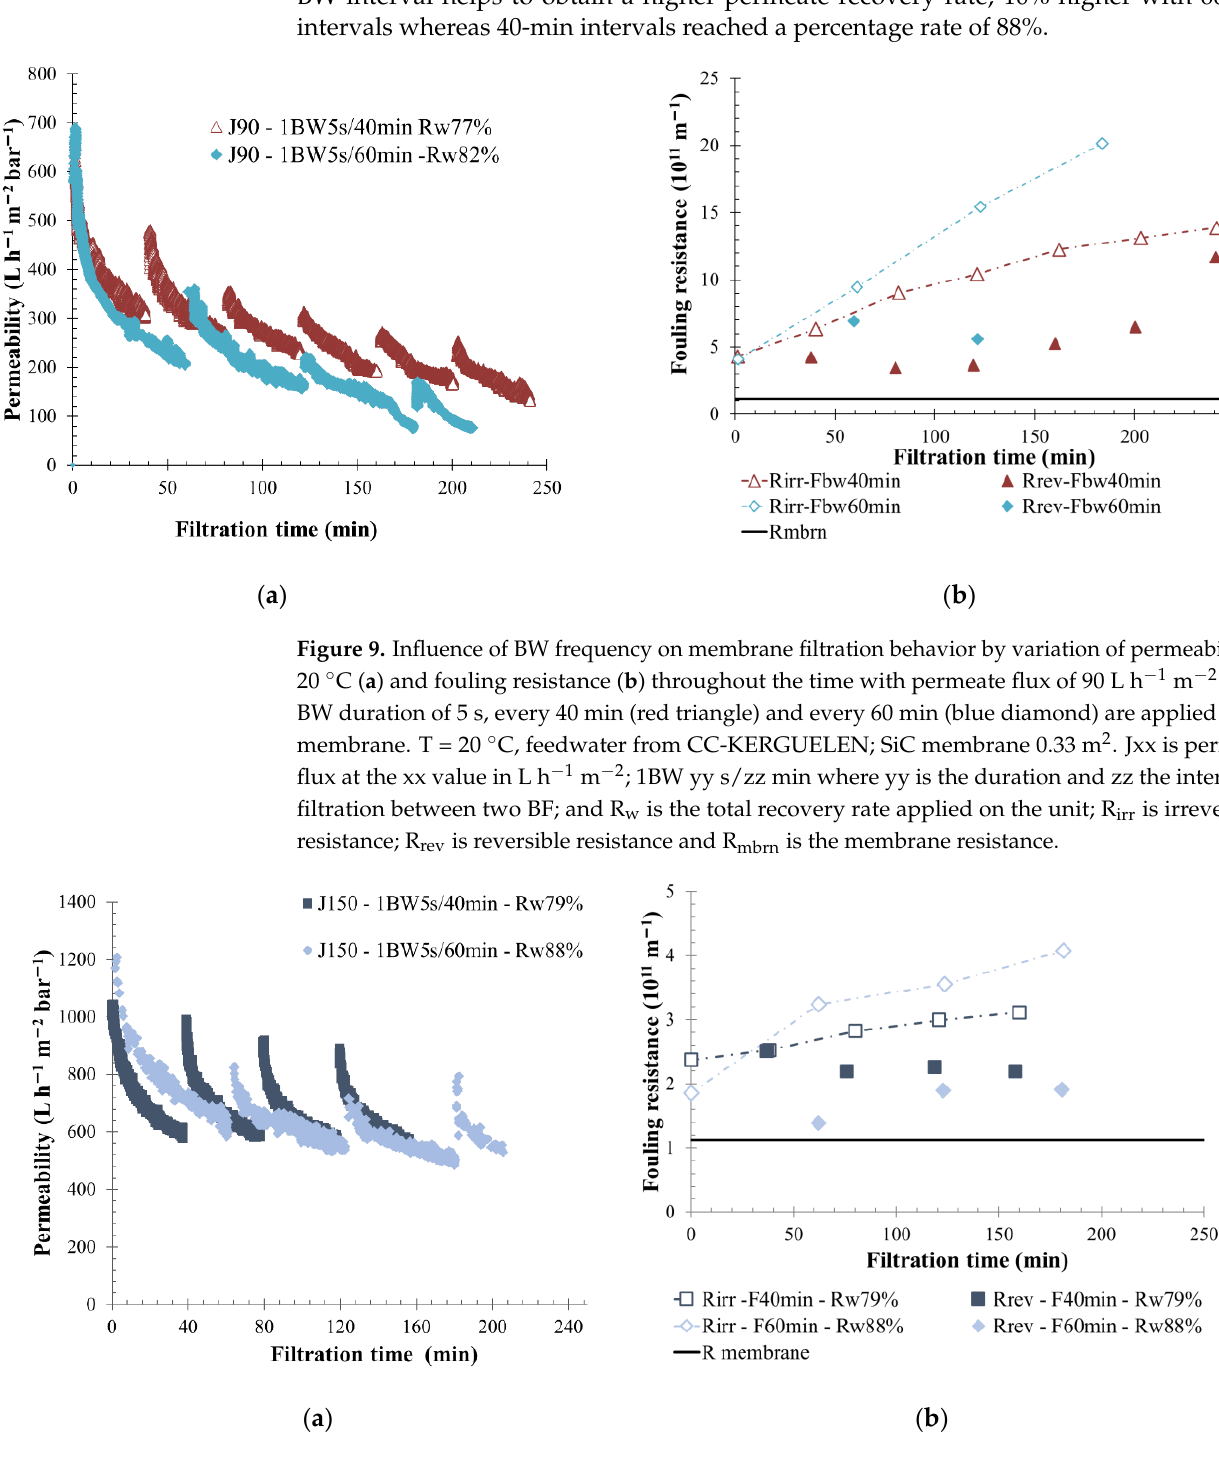
Figure 10. Influence of BW frequency on membrane filtration behavior by variation of permeability at 20 ◦ C ( a ) and fouling resistance ( b ) throughout the time with permeate flux of 150 L h − 1 m − 2 and a BW duration of 5 s, every 40 min (squared) and every 60 min (diamond) are applied to the membrane. T = 20 ◦ C, feedwater from APL-SINGAPURA ME; SiC membrane 0.33 m 2 . Jxx is permeate flux at the xx value in L h − 1 m − 2 ; 1BW yy s/zz min where yy is the duration and zz the interval of filtration between two BF; and R w is the total recovery rate applied to the unit; R irr is irreversible resistance; R rev is reversible resistance and R membrane is the membrane resistance.